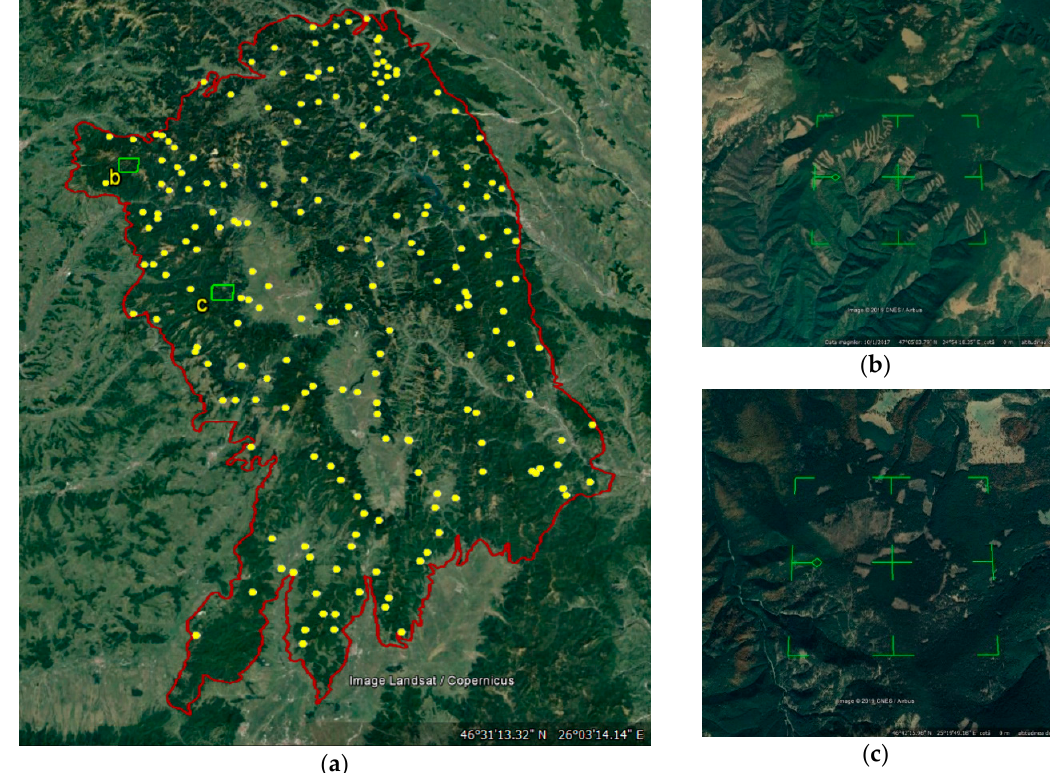
Figure 3. ( a ) Random ground reference test points used for the accuracy assessment of Central Carpathians marked with yellow points; the two plots marked in light green square from the top ( b ) to the bottom ( c ) are representative plots with clear deforested areas; ( b ) Clear cuttings in Vatava TAU in C ă limani Mountains; ( c ) Clear cuttings from 2017 in the Joseni TAU in Gurghiu